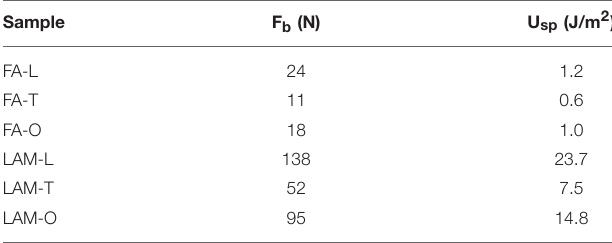
TABLE 5 | Results of Charpy impact tests on the two prepared laminates, performed in different orientations.